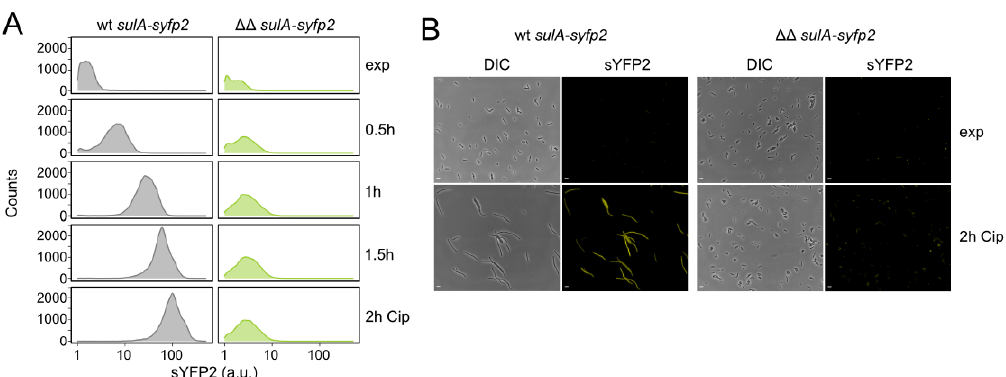
Figure 4. Inhibition of sulA expression in mutant ∆ 1-41 ∆ istR upon ciprofloxacin. ( A ) Flow cytometry analysis of sulA-syfp2 fusion strains treated with Cip. Cell samples were taken during the exponential phase (exp, OD 600 of ~0.4) and at indicated time points of Cip treatment (0.1 µ g mL − 1 ; 10 × MIC). Event counts were normalized to 10,000 events. ( B ) Differential interference contrast (DIC) and fluorescence (sYFP2) microscopy images of strains harboring chromosomal sulA-syfp2 fusions during exponential phase (exp, OD 600 of ~0.4) and after two hours of Cip treatment (0.1 µ g mL − 1 ; 10 × MIC). Scale bars indicate 5 µ m. (wt: wild type MG1655; ∆∆ : ∆ 1-41 ∆ istR